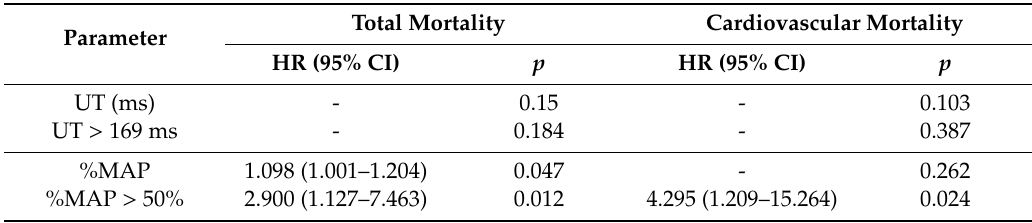
Table 5. Predictors of total and cardiovascular mortality using the Cox proportional forward hazards model in the multivariate